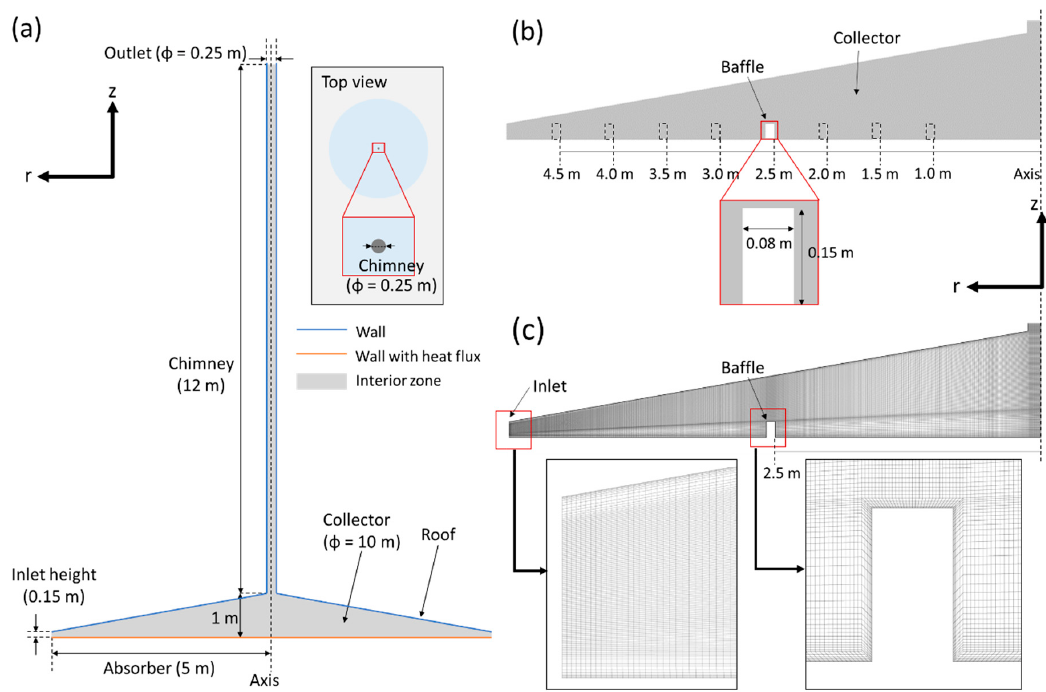
Figure 2. The 2-D axisymmetric geometry of the computational domain used in this study: ( a ) The base 2-D axisymmetric geometry of SUT. ( b ) A detailed view of the baffle models with different baffle locations, which are measured from the center (axis). ( c ) A quadrilateral grid system applied for meshing the whole computational domain and zoomed inset images showing the grids near the inlet and baffle (for the BL_2.5 model). Table 1. The eight models with different baffle distances from the central axis and control model (base case) for the case without baffle: Note that the number in each model name means the distance value.